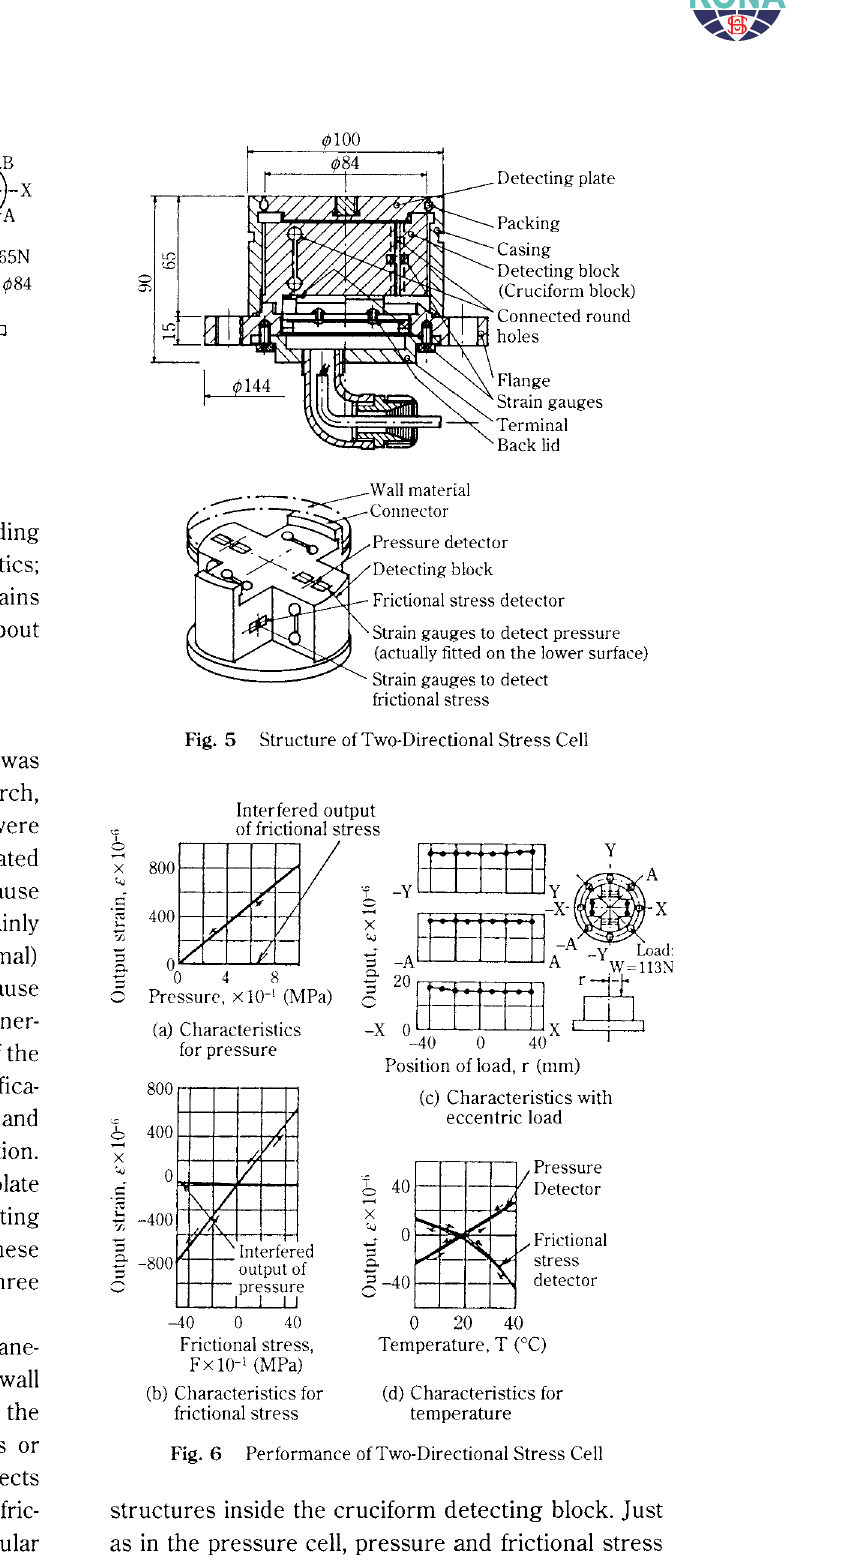
Fig. 6 Performance of Two-Directional Stress Cell structures inside the cruciform detecting block. Just as in the pressure cell, pressure and frictional stress are detected as changes in electrical resistance from the strain gauges attached to the plates. Performance graphs for this two-directional stress cell (Fig. 6) show pressure detection performance (a) and frictional stress detection performance (b). All show good linearity, nonhysteresis, and sensitivity. They also indicate that pressure interference in